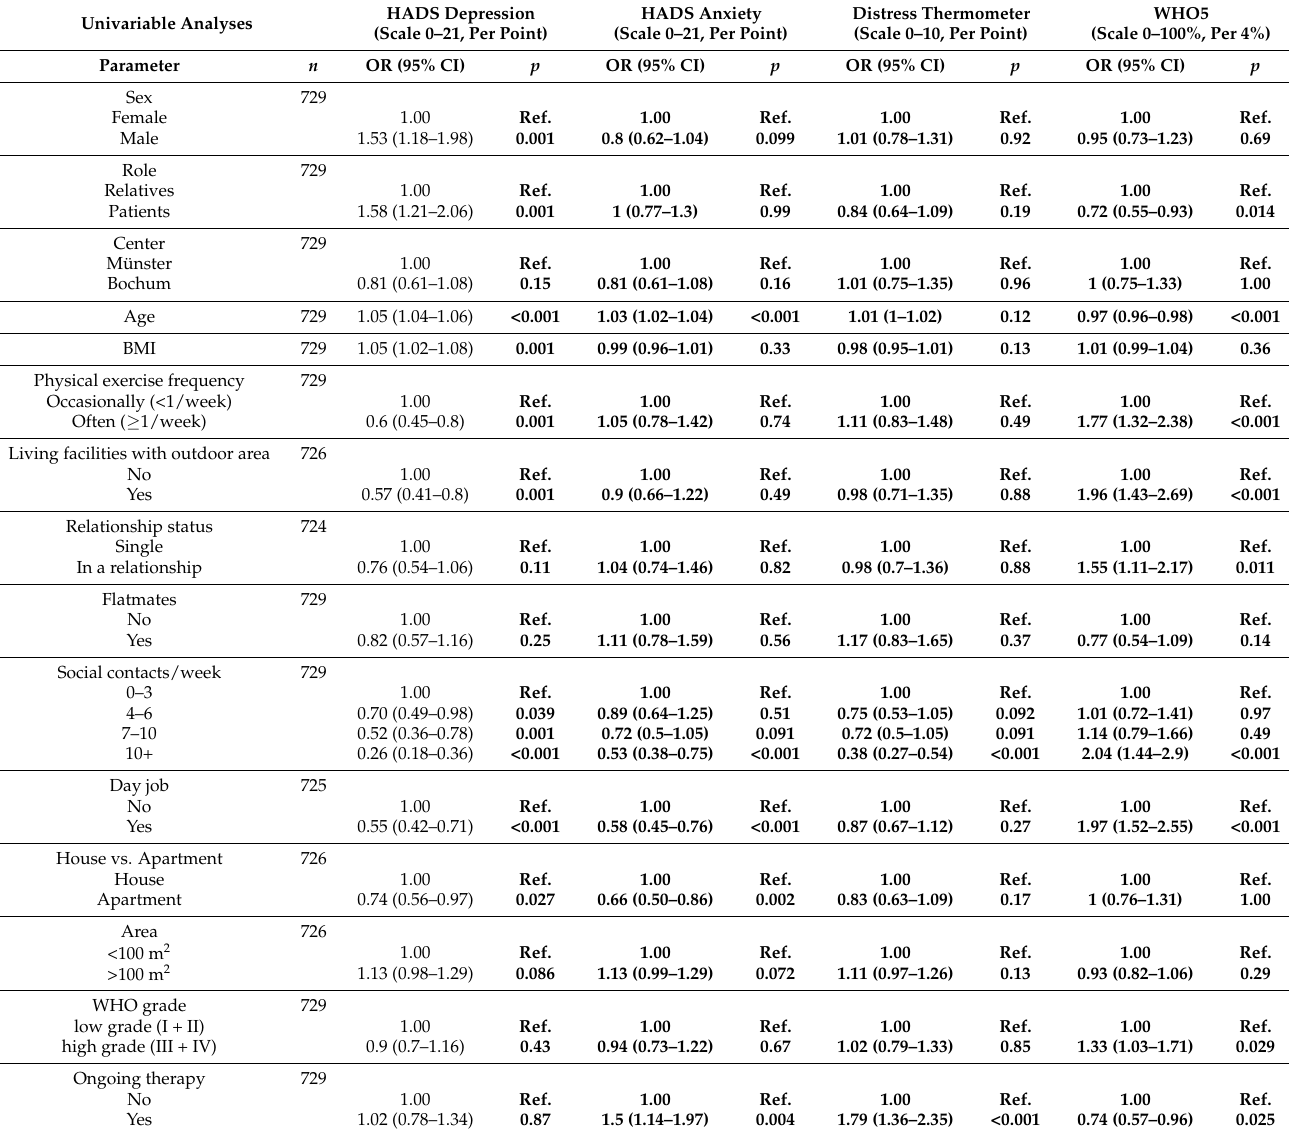
Table 2. Univariable ordinal logistic regression analyses correlating depressive symptoms and anxiety as measured by the Hospital Anxiety and Depression Scale (HADS), distress as measured by the distress thermometer, and well-being as quantified by the WHO5 scale with participant characteristics. Odds ratios, 95% confidence intervals, and p values are given for each